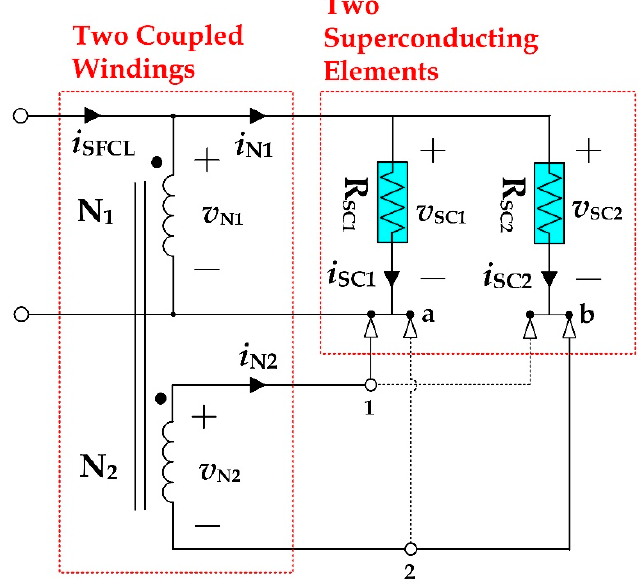
Figure 2. Electrical equivalent circuit of the SFCL using two magnetically coupled windings.